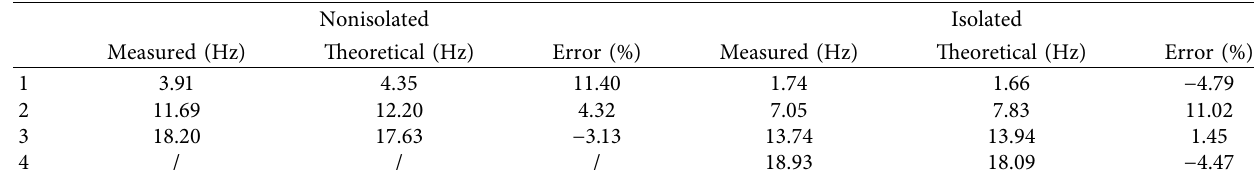
Table 4: Frequency of the experimental system.